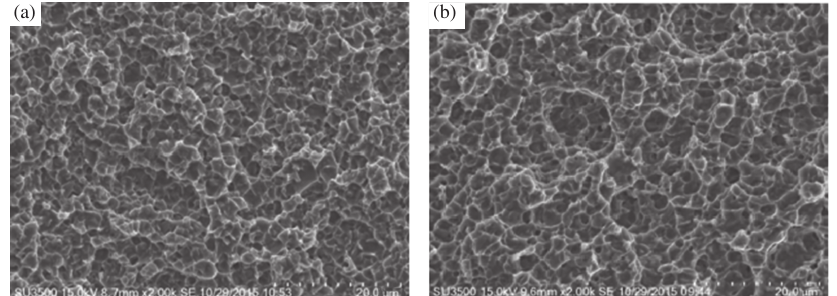
Figure 9: Fracture surface morphology of different thick joints: (a) 2mm and (b)